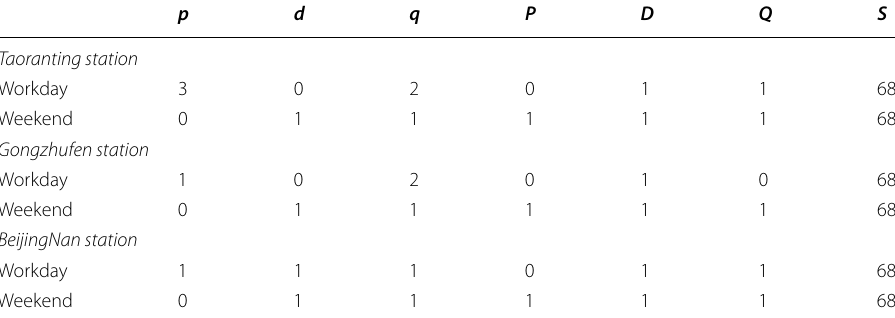
Table 1 Parameter of SARIMA